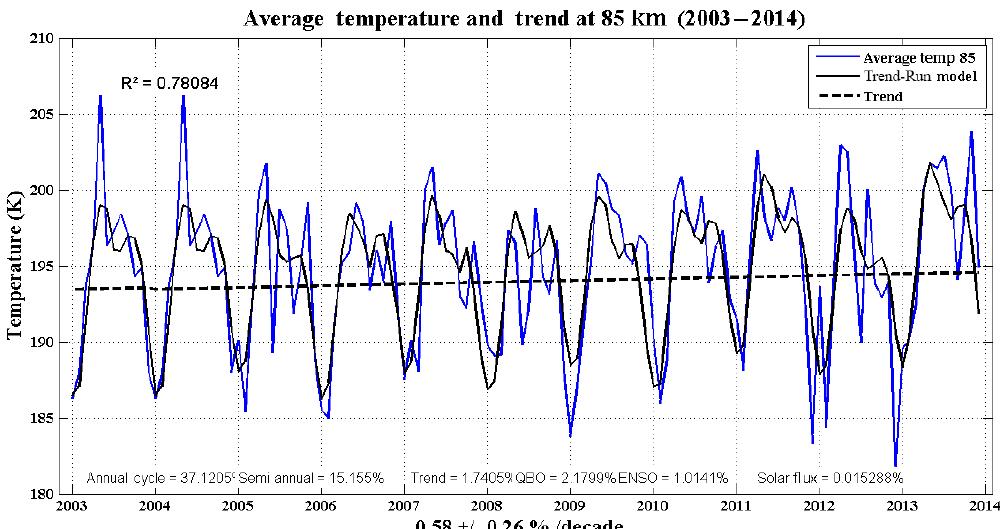
Figure 6. Time evolution of monthly averaged temperature values at 85km height over Santa Maria, within a ± 7.5 ◦ grid. The dashed straight line indicates the obtained linear trend ( + 0.58 ±− 0.26%Kdecade − 1 ) from the Trend-Run model.